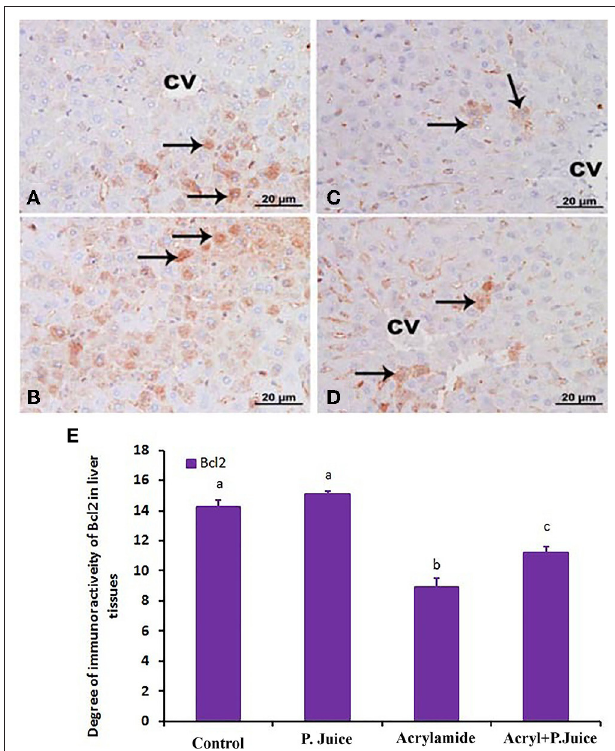
FIGURE 6 | Photomicrographs of hepatic sections immunostained with Bcl2 antibody in the control group (A) , the TPJ group (B) , the acrylamide-treated group (C) , and the group co-treated with TPJ and acrylamide (D) . The intensity of immunostaining was remarkable in the control and TPJ-treated groups (A,B) , less in the acrylamide-treated group (C) , and ameliorated and restored in the co-treated rats (D) . Reactive liver cells (arrows) are frequently seen next to CVs. Scale bar = 20 µ m (original magnification = 200 × ). The degree of positive immunoreactivity for Bcl2 is graphed in (E) . Densitometric values are statistically significant at * p < 0.05 vs. the control and TPJ-treated groups; # p < 0.05 vs. the acrylamide-administered group. In panel E, means with different letters indicate significance ( p <